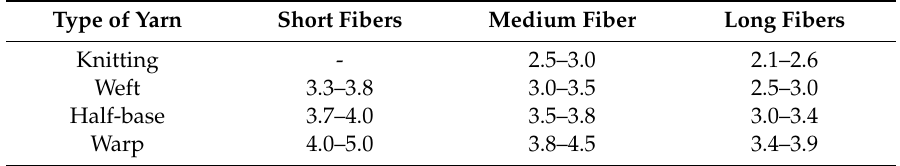
Table 2. Coe ffi cient of twist, α e , according to the useful properties of the yarn produced [9]. Type of Yarn